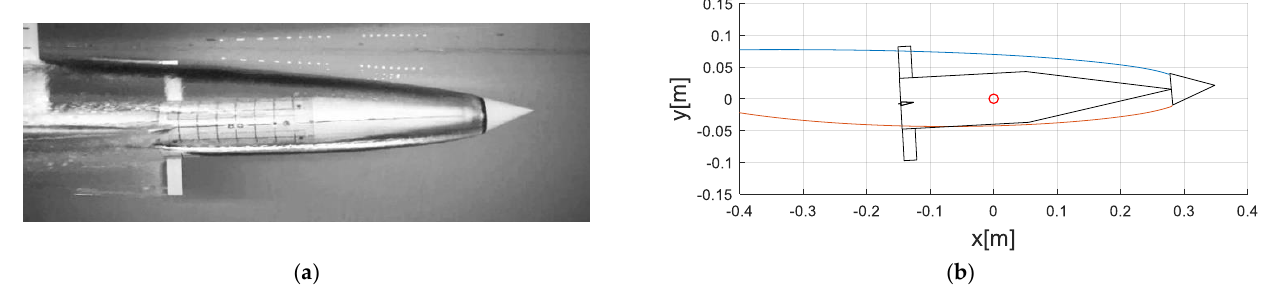
Figure 9. Experimental and calculated trim conditions in a steady planing mode (disk-type cavitator. V = 9.12 m/s, 𝜎 = 0.064) : ( a ) experiment; ( b ) calculation. Figure 10. Experimental and calculated trim conditions in a steady planing mode (cone-type cavitator. V = 9.58 m/s, 𝜎 = 0.061) : ( a ) experiment; ( b ) calculation.